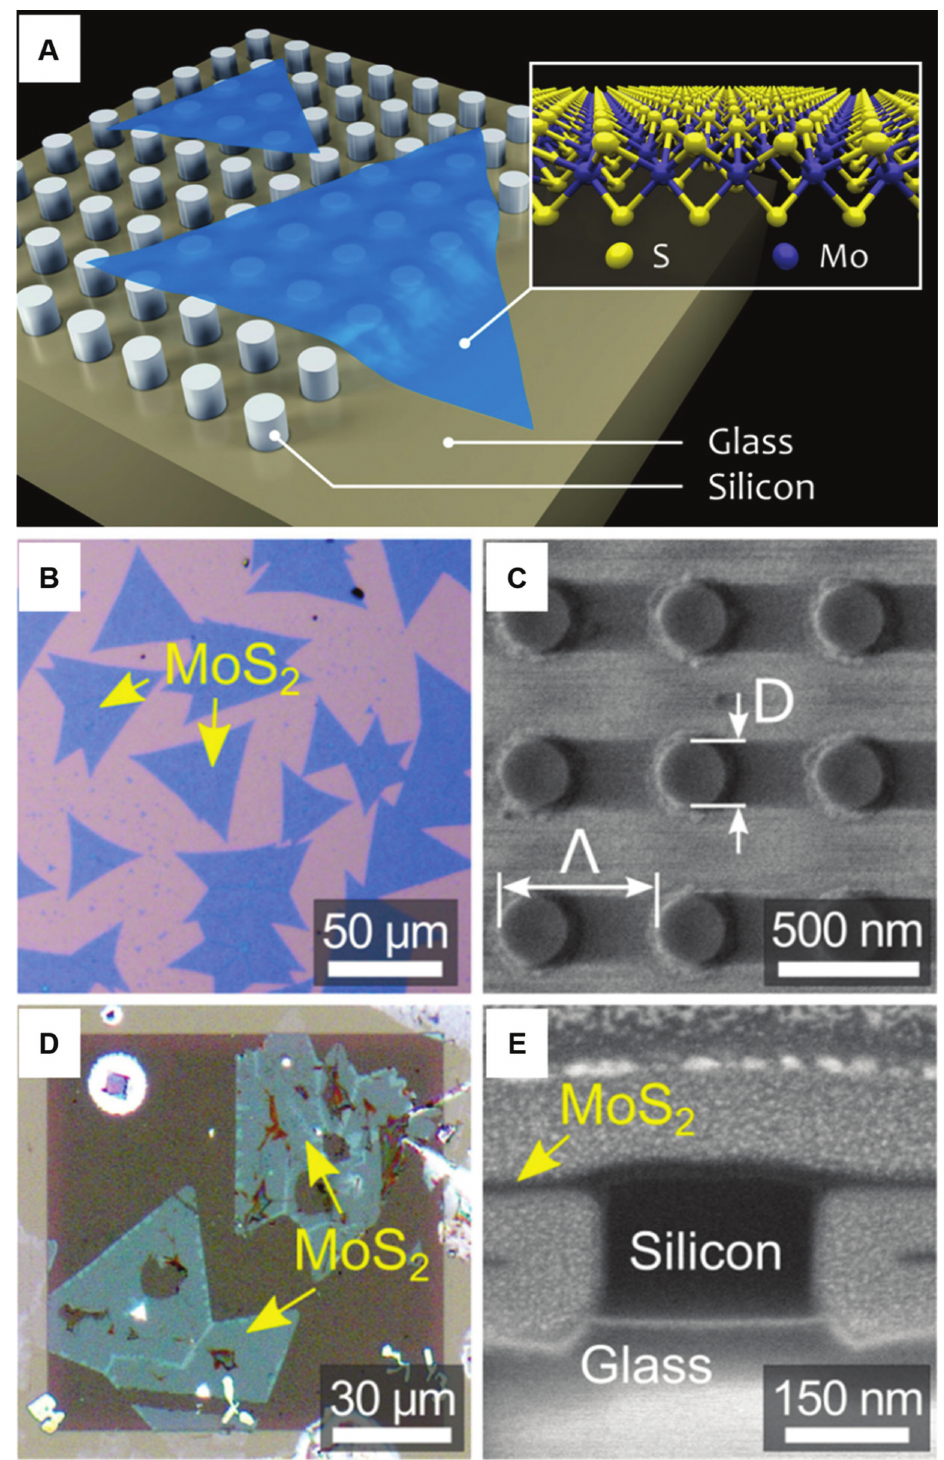
integrating with all-dielectric metasurface. Figure 9: Monolayer MoS 2 (A) Sketch of MoS monolayers placed on top of Si nano-cylinder metasurface on a glass substrate. Inset shows the crystal structure. 2 (B) Real-color optical micrograph of MoS monolayers on the Si wafer. (C) Top-view SEM micrograph of a Si metasurface on glass. (D) Real- 2 color optical micrograph of MoS monolayers on a Si metasurface. (E) Cross-sectional SEM micrograph of the same sample in (D), where an 2 area covered by monolayer MoS . Reprinted with permission of Ref. 2